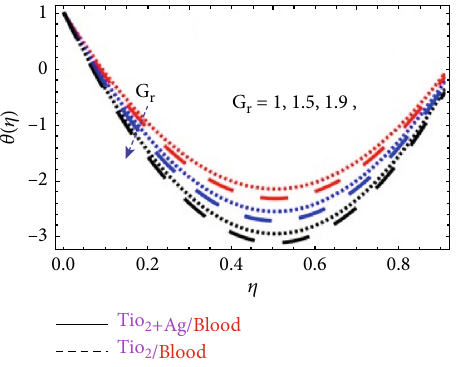
on temperature r